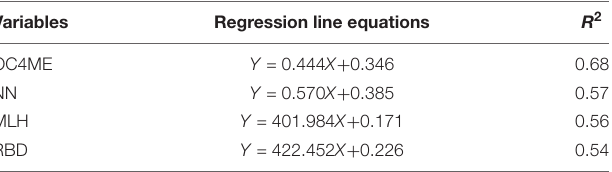
TABLE 1 | Equations and determination coefficients of regression lines for in-situ chlorophyll- a concentrations and satellite-derived variables. Variables